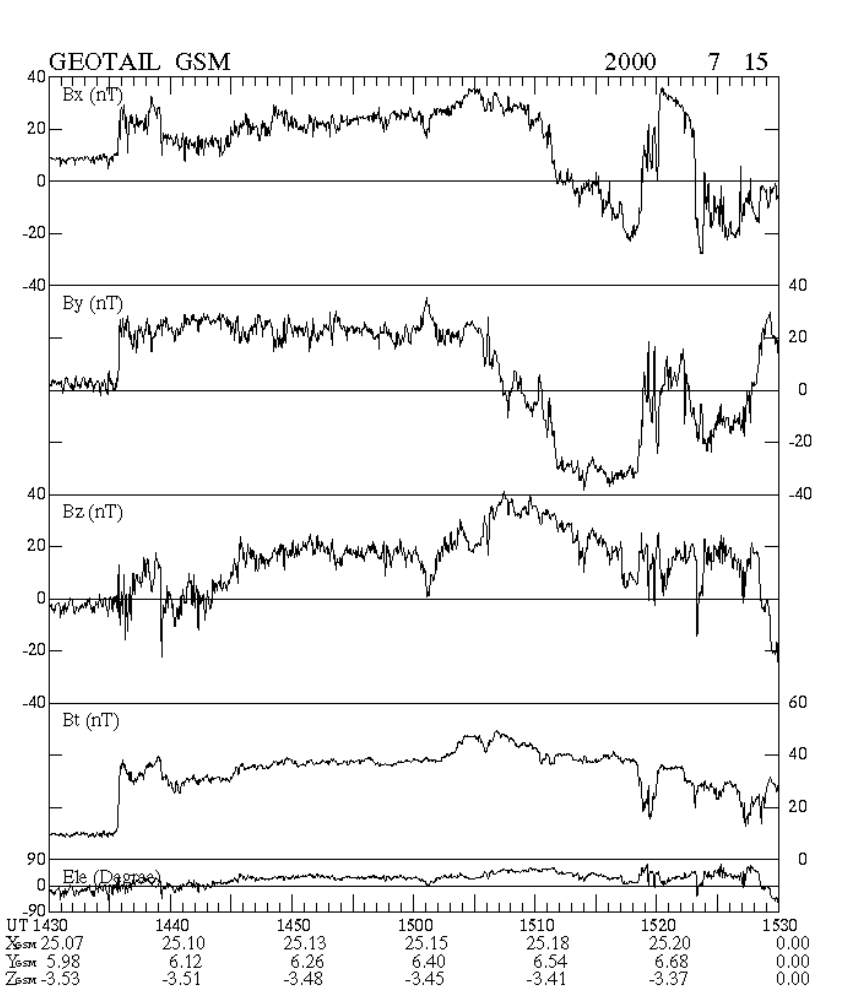
Fig. 12. The IMF components ( B x , B y , and B z ) and value of the total magnetic field ( B ) as measured by the Geotail satellite on 15 July